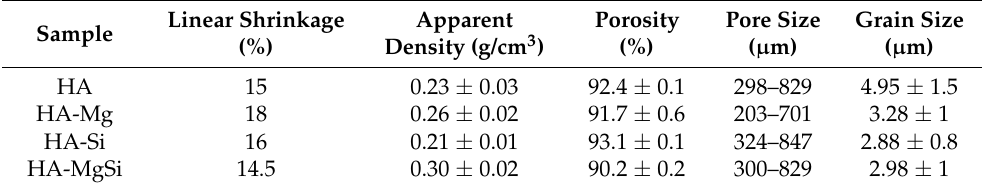
Table 2. Linear shrinkage, apparent density, porosity, pore size ranges and grain size of synthesized scaffolds.